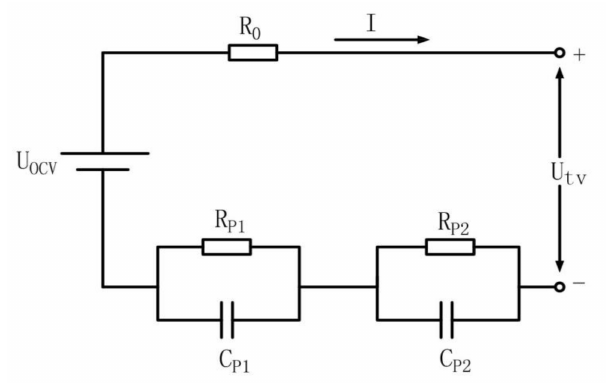
Figure 1. DP model circuit